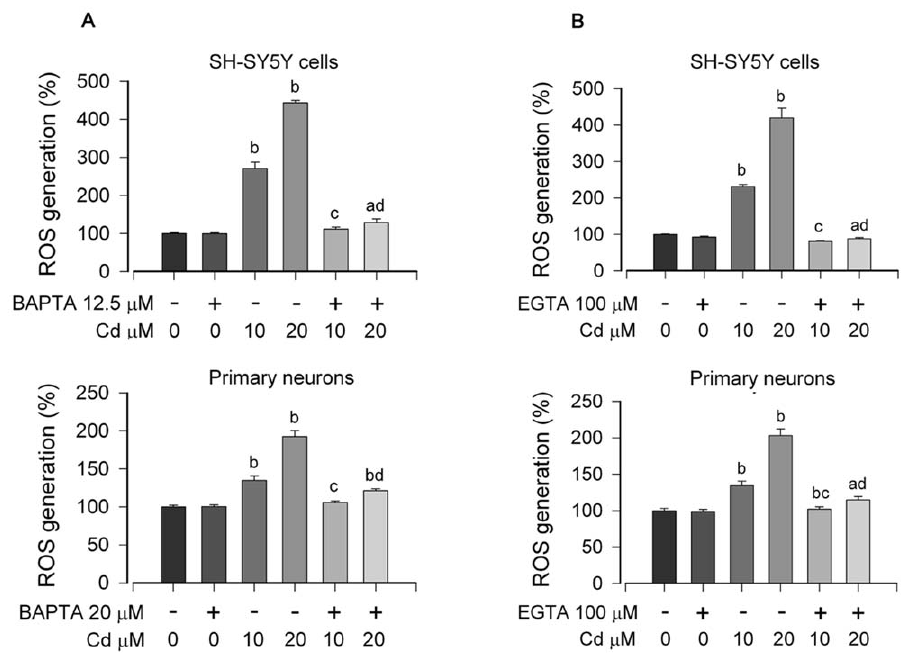
Figure 6. Cd-elevated [Ca 2 + ] i induces ROS in neuronal cells. Indicated cells were exposed to 0–20 m M Cd for 24 h after pretreatment with/ without indicated concentrations of BAPTA/AM (A) or EGTA (B) for 30 min, followed by ROS detection, as described in Materials and Methods. Results are presented as mean 6 SE; n =6. a P , 0.05, b P , 0.01, difference vs. control group; c P , 0.01, difference vs. 10 m M Cd group; d P , 0.01, difference vs. 20 m M Cd group.